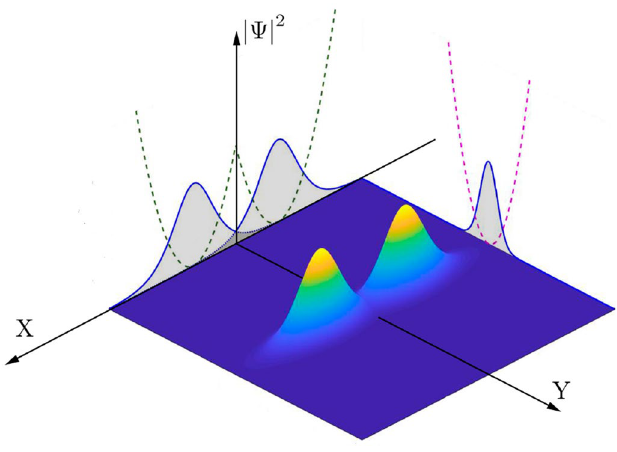
2 versus spatial coordinates X and Y , as a 2D (cid:31) | |